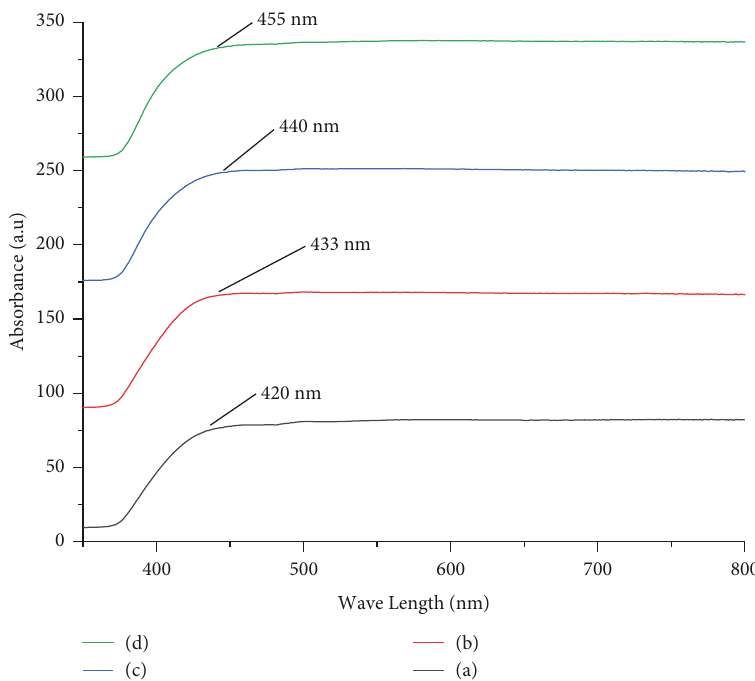
Figure 4: Absorbance spectra of Fe TiO 2 NPs at PH value of (a) PH (cid:31) 2, (b) pH (cid:31) 4, (c) pH (cid:31) 5, and (d) pH (cid:31) 6.